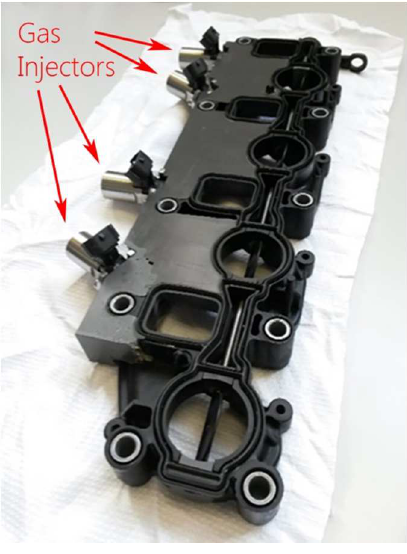
Fig. 6. Four PFI gas injectors mounted on the swirl flap adapter of the original Diesel engine